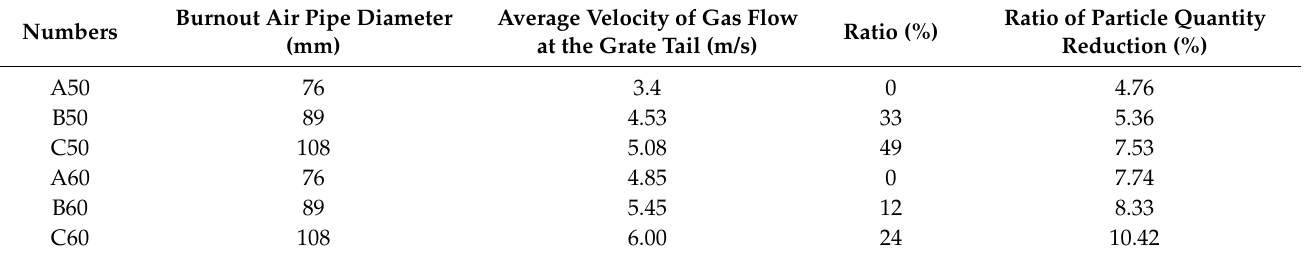
Figure 7. Flow line distribution in furnace. Table 5. Variation average speed of the gas flow at the tail of the furnace at different pipe diameters.